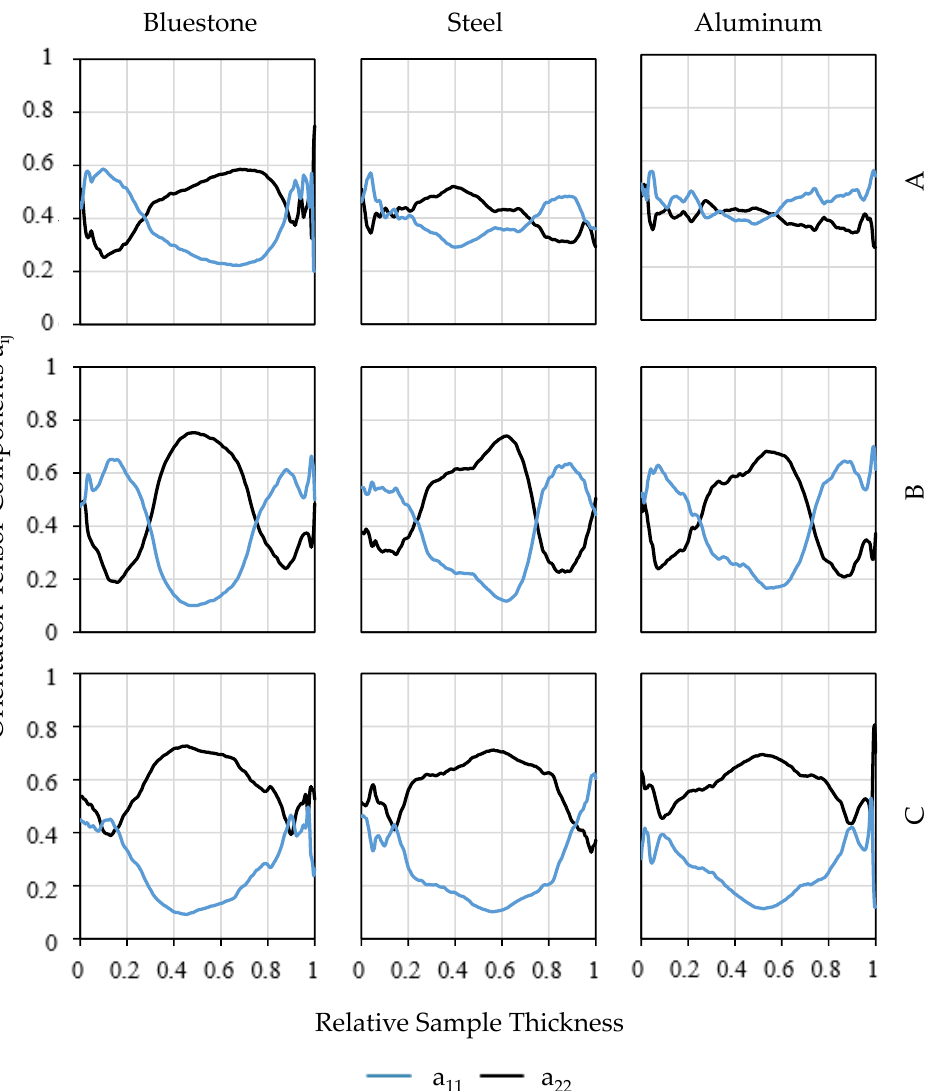
Figure 22. Orientation tensor components ( a 11 , a 22 ; without a 33 for better overview) and relative sample thickness fora nominal fiber content of 60 wt.%. Specimens were created with Bluestone, steel, and aluminum tools, with samples from regions A, B, and C (in accordance with Figure 9).